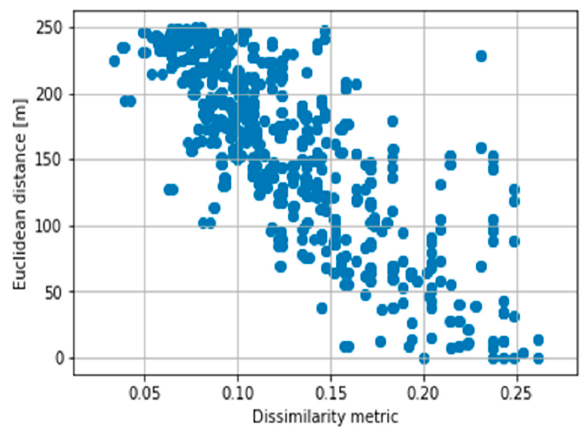
Figure 5. Euclidean distance versus dissimilarity metric for 120 vehicles.